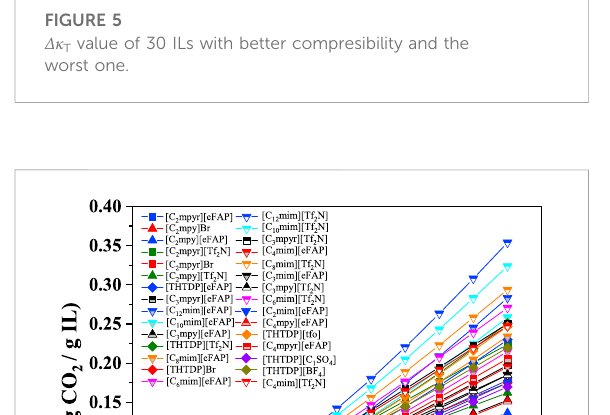
FIGURE 5 Δκ T value of 30 ILs with better compresibility and the worst one.